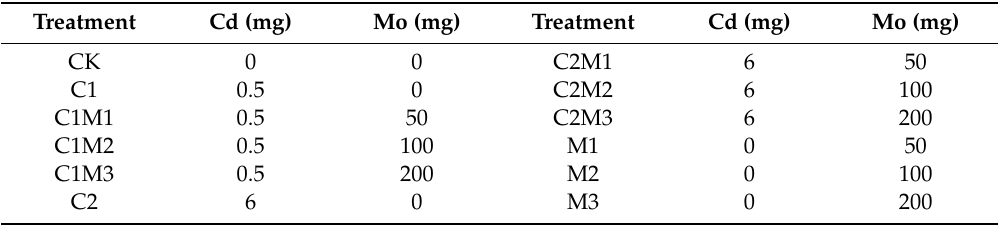
Table 1. Experimental design of heavy metal concentrations per kg of